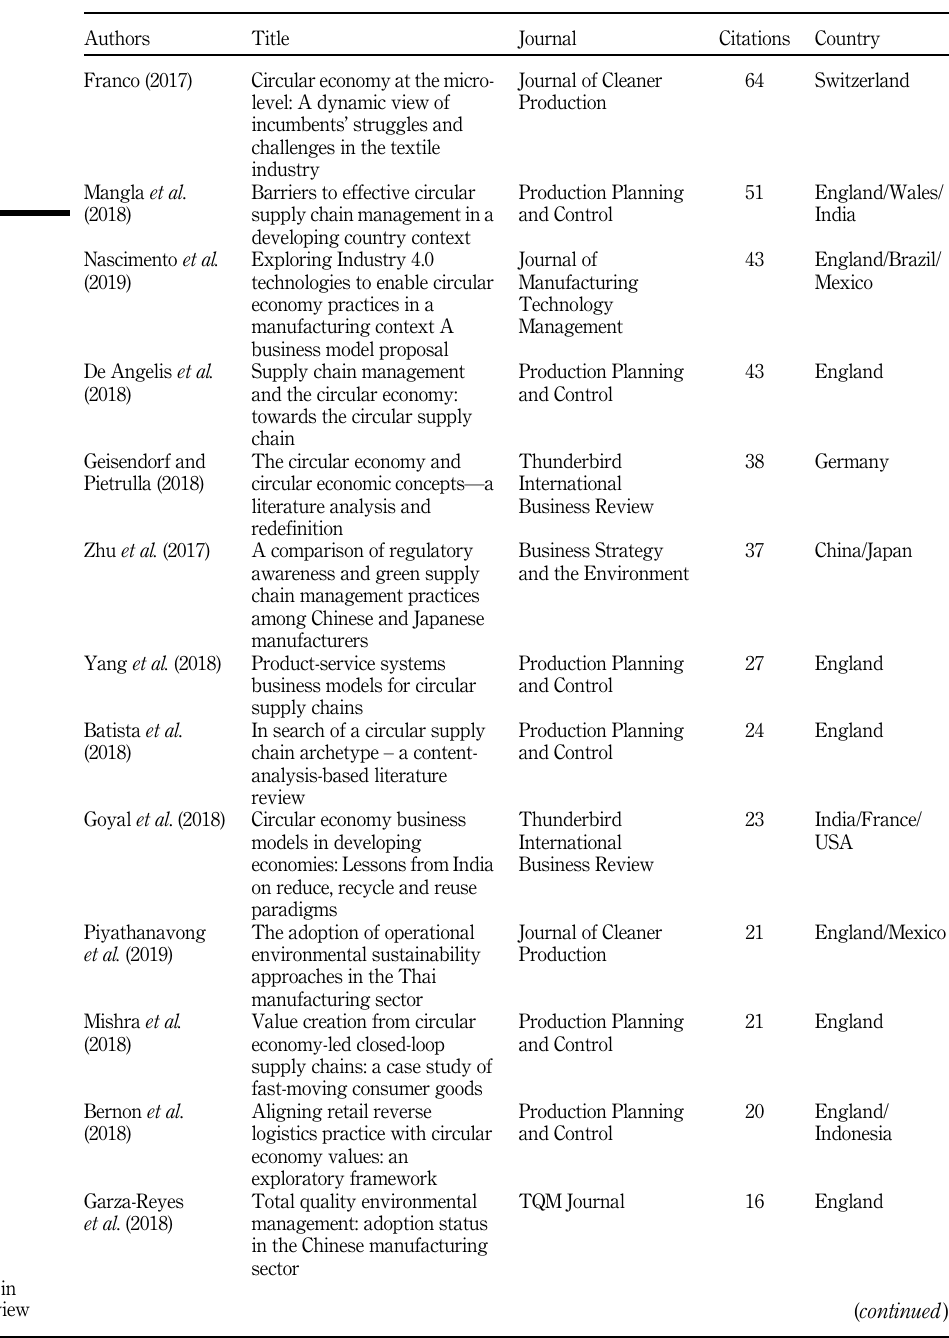
Table 5. Key literature in systematic